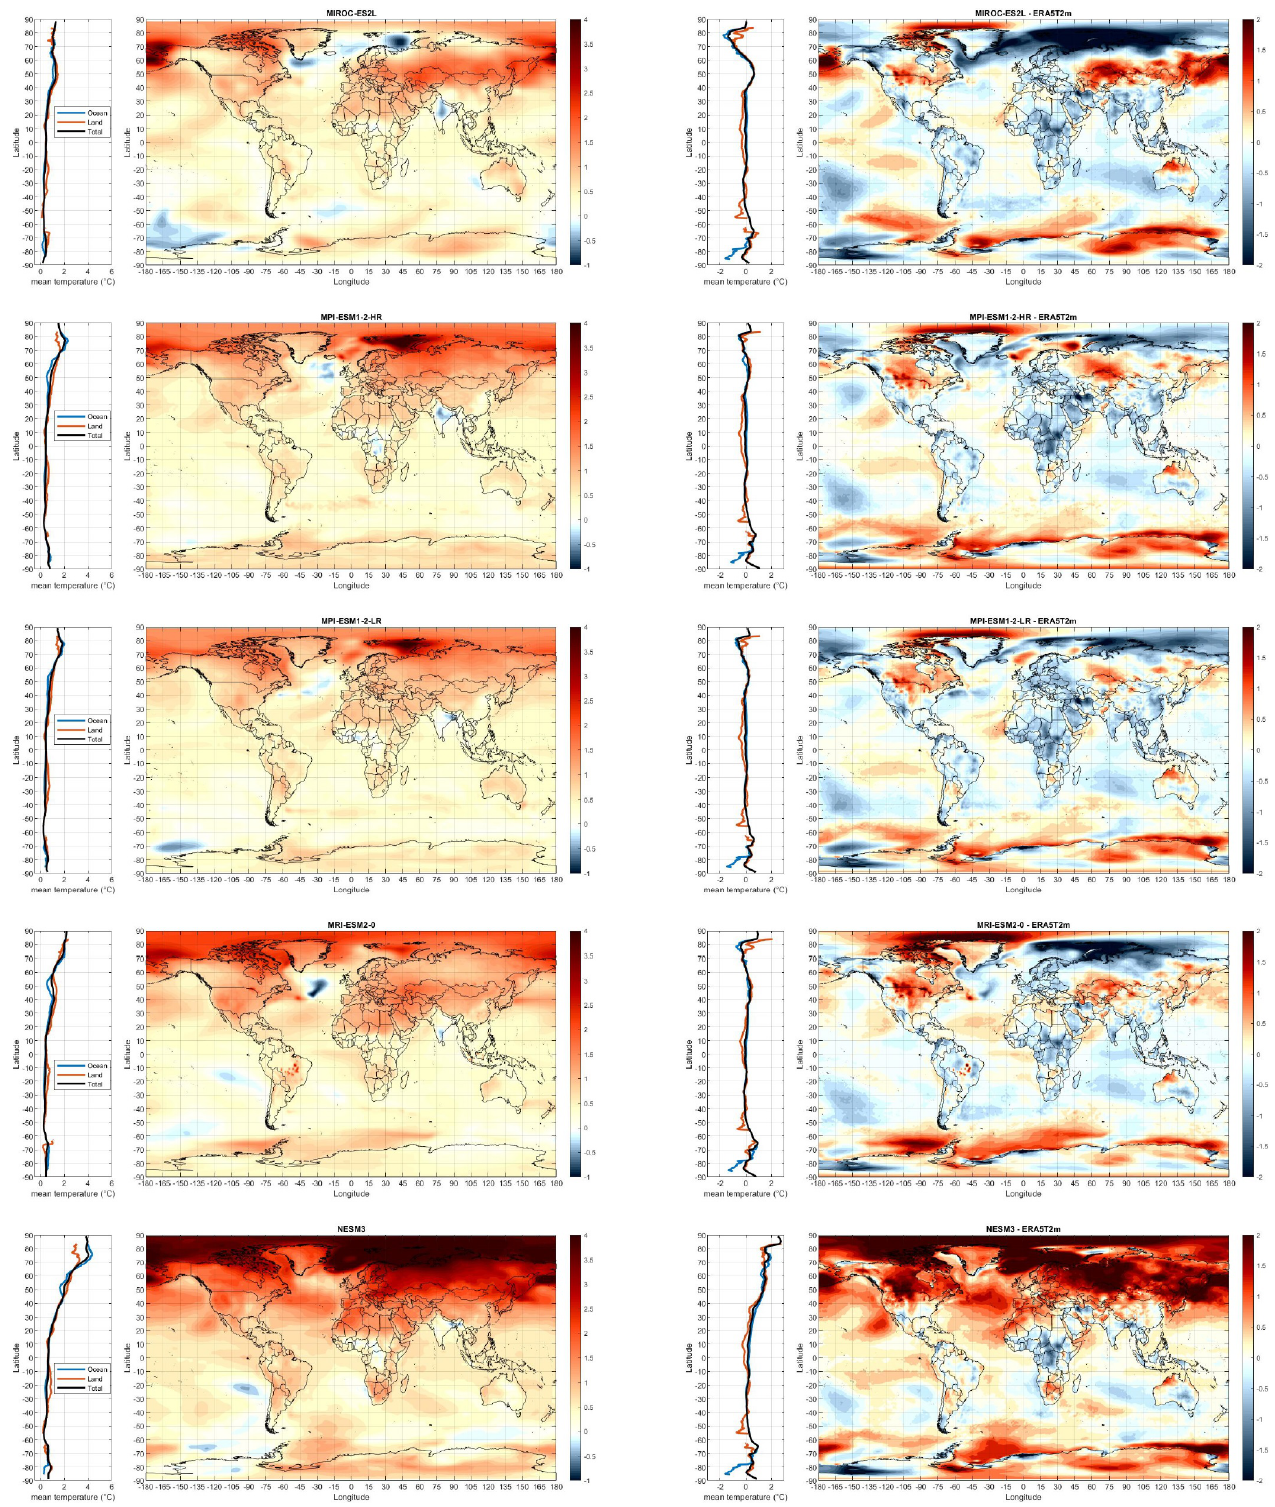
Figure A7. Warmingpatterns from 1980–1990 to 2011–2021 for the indicated CMIP6-tas GCM ( left ) and its comparison against the ERA5-T2m record ( right